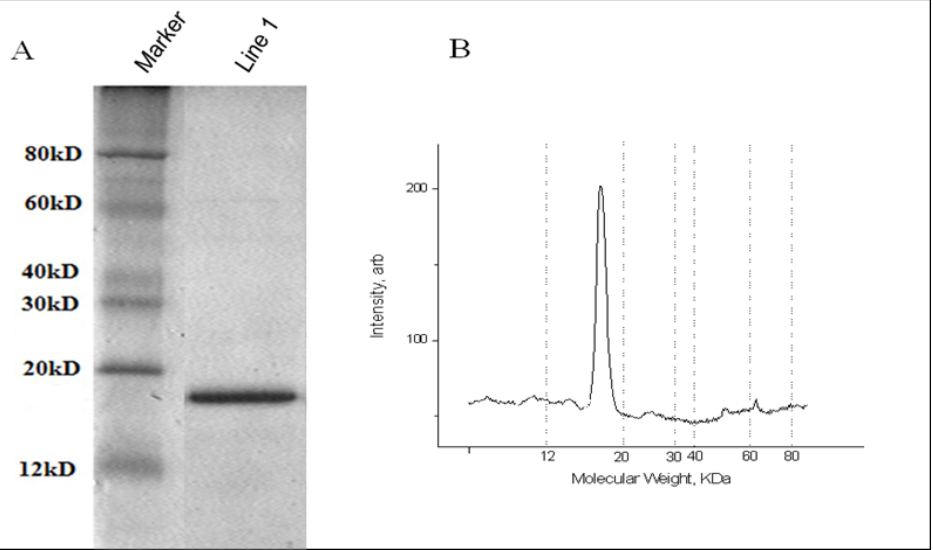
Figure 4. Scale-up of the expression of His-FIP-fve fusion protein. ( A ) His-FIP-fve eletrophoresised in line 1 by 15% SDS-PAGE, and ( B ) Densitometry of line 1 containing the purified His-FIP-fve fusion protein. The large peak corresponds to the purified protein representing